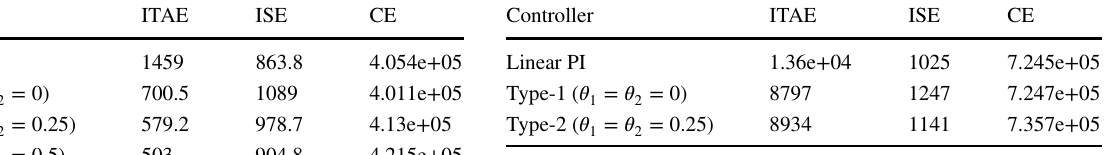
Fig. 13 Set-point responses of CTS with varying FoUs ( 0 ≤ 𝜃 1 ∕ 𝜃 2 ≤ 0.5 ) in the presence of (a) input disturbance, and (b) input disturbance and parameter variations Table 6 Performance indices for set-point response (CTS) Controller